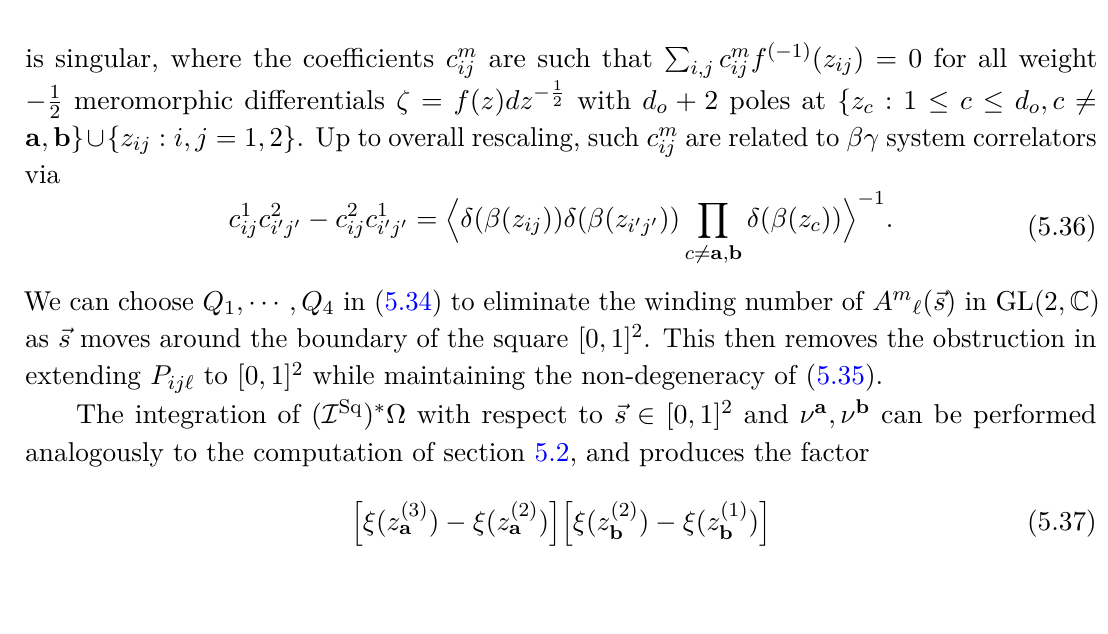
Figure 3 . An illustration of the interpolation map I Sq associated with a square move. The shaded square at the center represents the domain of the interpolation parameters ( s 1 , s 2 ) . The neighboring shaded domains are those of other interpolation maps. In each region, the (up to four) circles represent the nontrivial gluing maps of the discs centered at z ij on the SRS. An arrow pointing between two circles indicates interpolation between the gluing maps as s 1 or s 2 varies, in accordance with the pattern of PCO movement. Matching the boundaries segments of I Sq to the neighoring segments of the integration contour involves further GL(2 , C ) rotations on the fermionic coordinates ( ν a , ν b ) by Q i